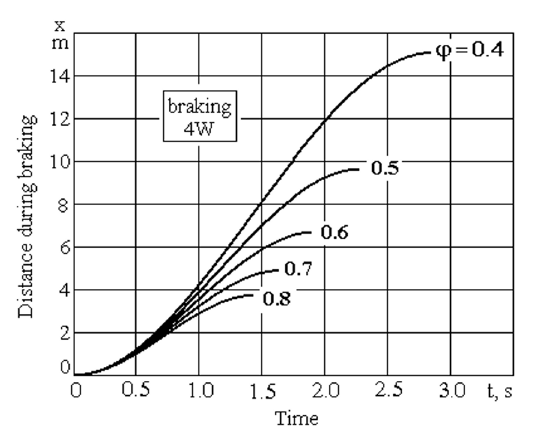
Figure 7. Variation of distance covered by the tractor during braking taking into account the time to a complete stop, for 5 val- ues of the coefficient of road adhesion - braking applied on all wheels.